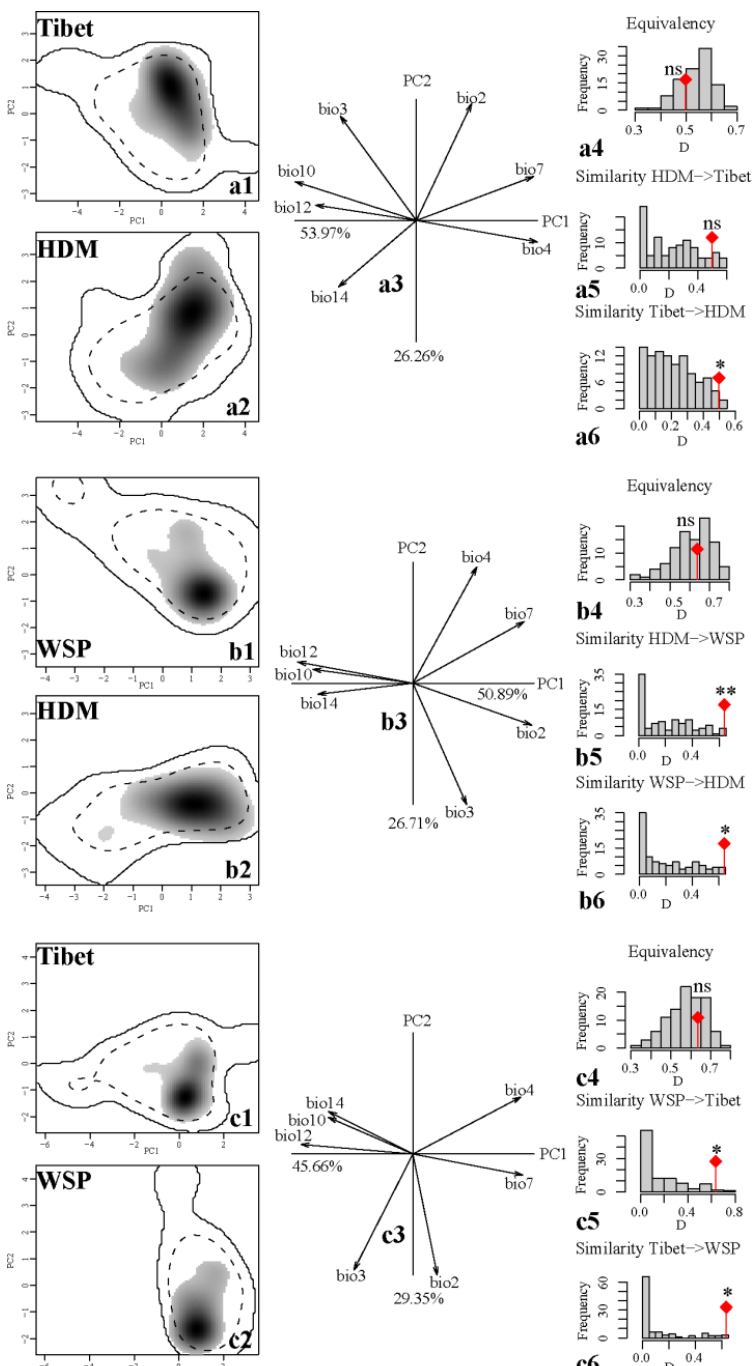
Figure 5. The niche dynamics of the three compared pairs within Quercus aquifolioides in climate space based on a principal component analysis (PCA-env). Panels ( a – c ) are the niche features of the three compared pairs along the two first axes of the PCA, respectively. In panels ( a1 , a2 , b1 , b2 , c1 , c2 ), shadow areas colored in gray represent the density of the occurrences of the lineage by cell. The 100% and 50% of the available environment are delimited by solid and dashed contour lines, respectively. Panels ( a3 , b3 , c3 ) indicate the contribution of the environmental variables on the first two axes of the PCA and the percentage of inertia interpreted by the PCA axes. Histograms in a4-6, b4-6, and c4-6 represent the observed niche overlap ( D ) between the two lineages (bars with a diamond) and simulated niche overlaps (gray bars) based on the tests of niche equivalency and niche similarity, respectively. The significance of the tests is shown (ns, non-significant; * 0.01 < p < 0.05; ** p <